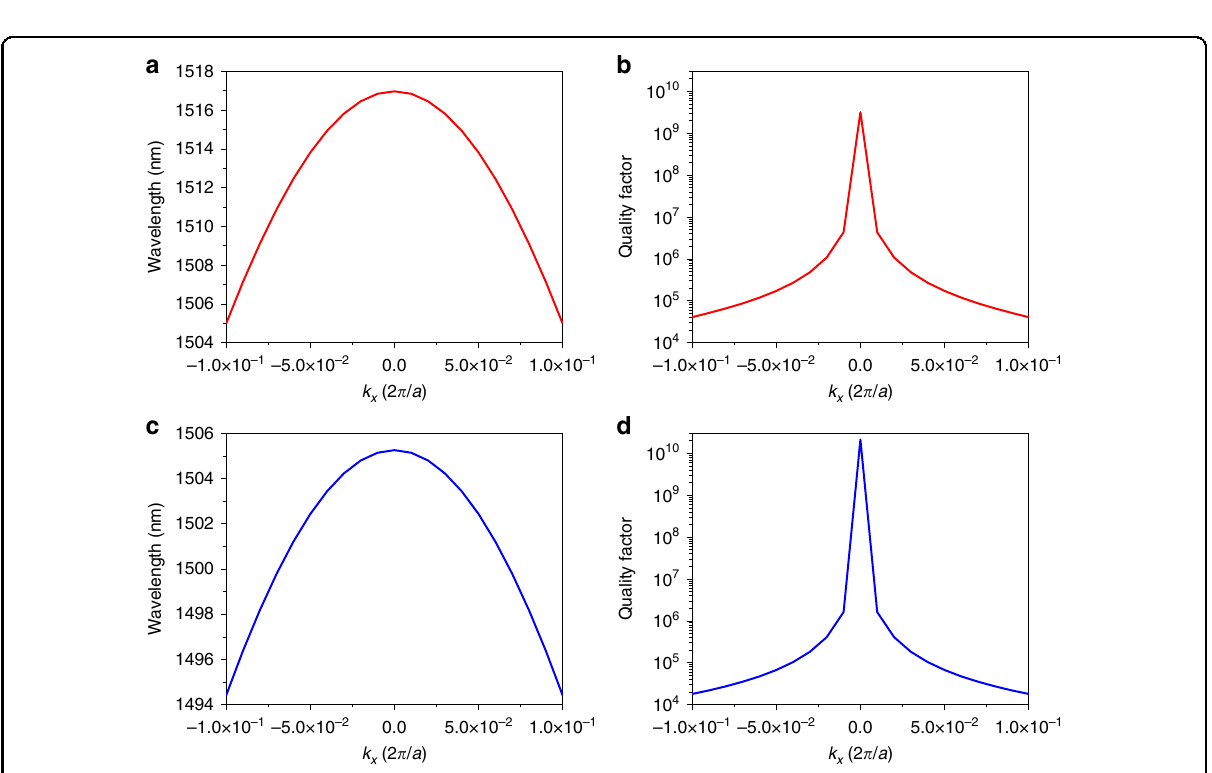
Fig. 4 Evolution of BIC eigenmode in the twisted PhCS. Wavelength and quality factor of the eigenmode in the twisted PhCS with ( a , b ) α = 18° and ( c , d ) α = 36°. The results are obtained with k top top